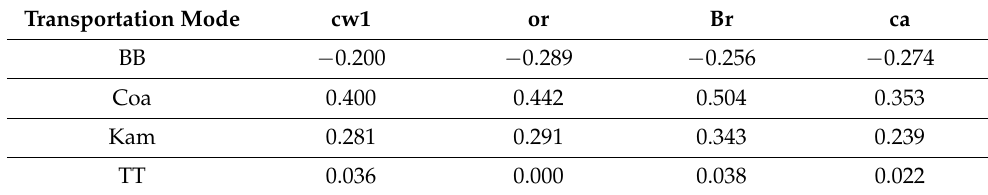
Table 6. The new MIS based on the generalized aggregation method (Equation (3)). Transportation Mode